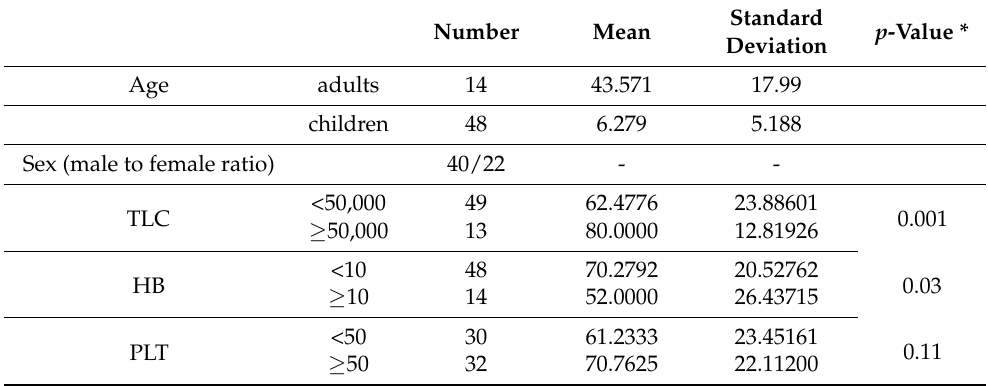
Table 1. Comparison between different laboratory data and CD200 expression with patient demographics. Number Mean